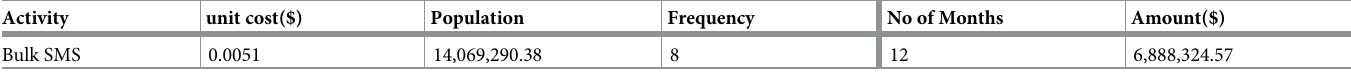
Table 7. Estimation of cost of public health awareness on snakebite in six states of NE Nigeria using mobile phone. Activity